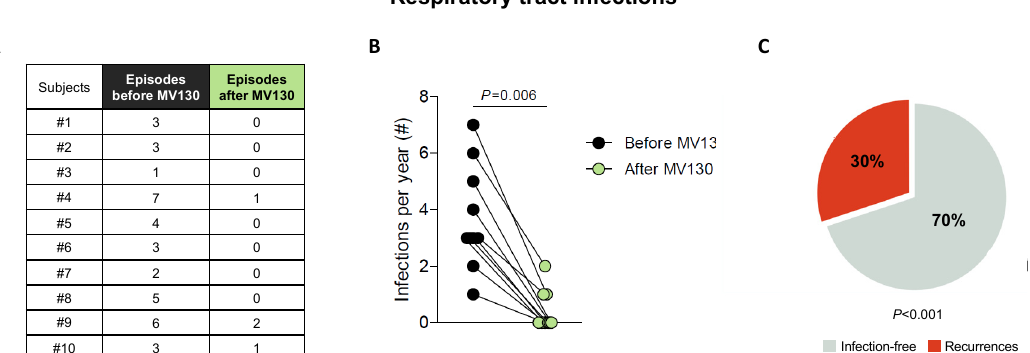
Figure 2. MV130 significantly reduces the incidence of respiratory infections ( A – C ). ( A , B ) Number of respiratory tract infectious episodes scored 1 year prior to immunization (black) and in the 12 months after the initiation of immunotherapy with MV130 (green). ( C ) Percentage of subjects that remained free of infection (grey) or su ff ered recurrences (red) in the 12 months following MV130 administration. Data from 10 subjects are shown. ( B ) Lines link paired values. Normal distribution was evaluated using the Shapiro–Wilk test, p value was calculated using Wilcoxon signed-rank test. ( C ) p value was calculated using Fischer’s exact test, compared with rates prior to MV130 initiation (100% of subjects su ff ering infections).